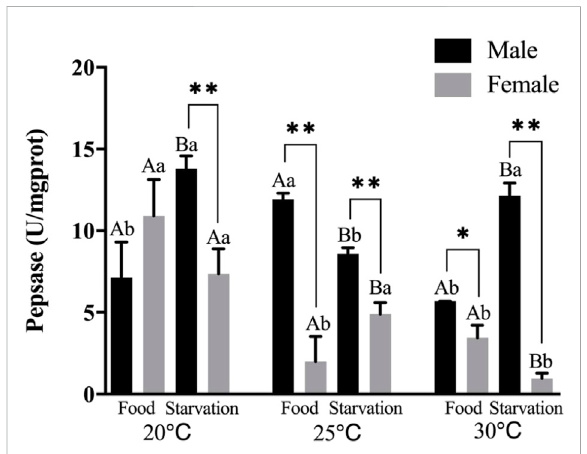
FIGURE 4 Pepsin (PEP) of different sex M. coruscus exposed to six combinations of temperature (20, 25, and 30 ° C) and the feeding condition (food and starvation) at 30 days during the exposure period.Differentcapitallettersindicatesigni fi cantdifferences between the feeding condition and each temperature levels (20, 25, and 30 ° C) ( p < 0.05). Different small letters indicate signi fi cant differences between temperature (20, 25, and 30 ° C) and the same feeding condition ( p < 0.05). Asterisk indicates signi fi cant differences between sex and each feeding condition, in which * representssigni fi cantdifference( p < 0.05)and**representshighly signi fi cant difference ( p < 0.01).